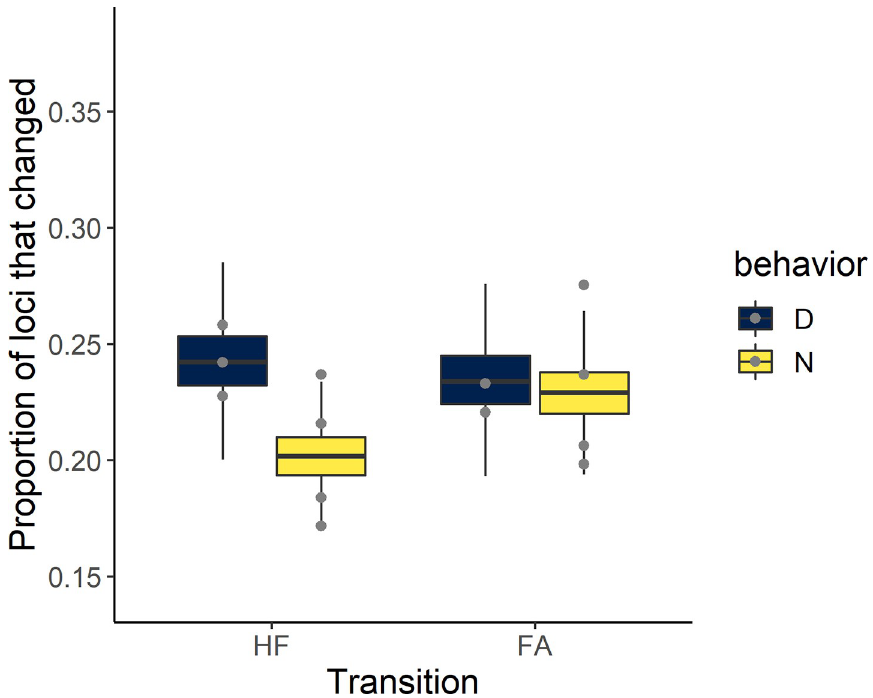
Fig 2. Mean proportion of loci that changed methylation status (gained or lost methylation) during the transition from hatchling to fledgling or from fledgling to adult. Boxplots represent summaries of the posterior distribution for dispersing and philopatric birds and data points are the raw